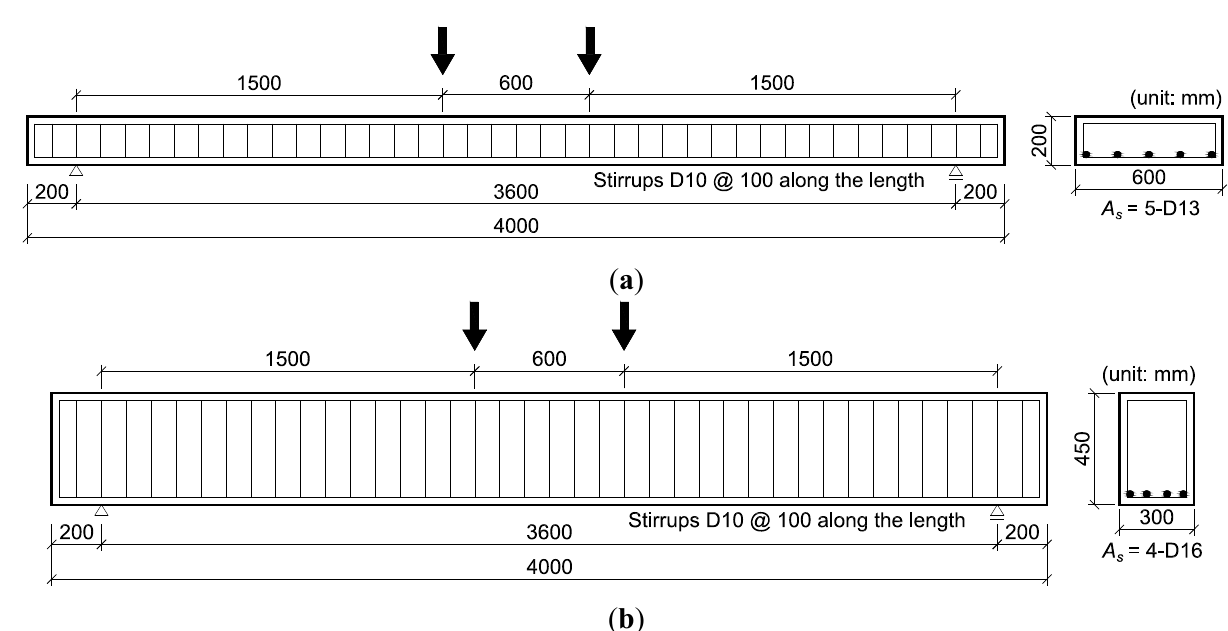
Figure 3. Details of test specimens of ( a ) slab specimen and ( b ) beam